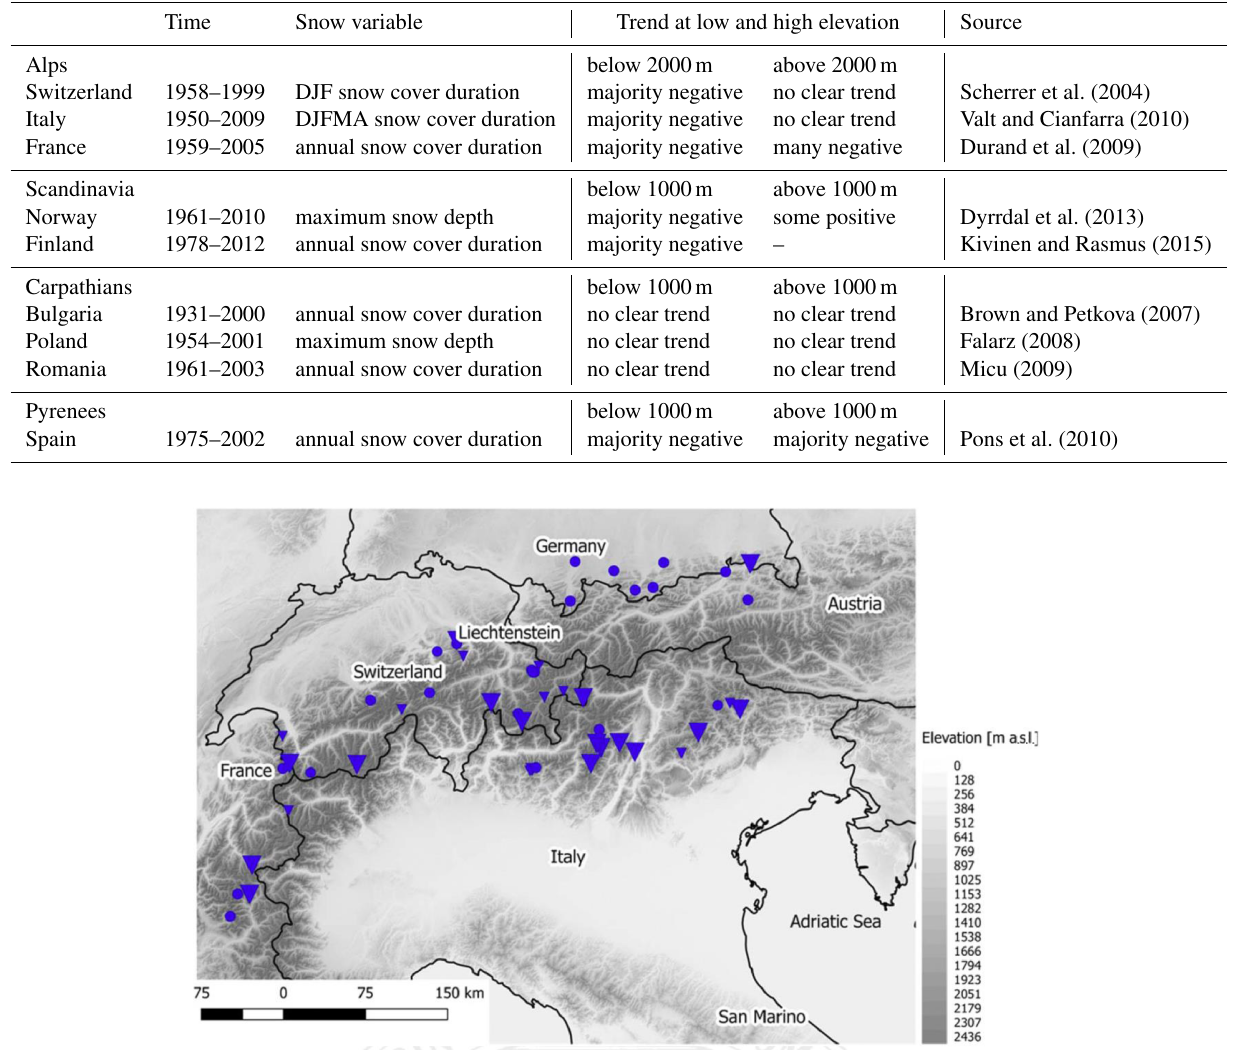
Figure 1. Geographical distribution of the 45-year trend (1968–2012) for 1 April snow water equivalent (SWE) in the Alps. All stations show a negative trend. Large triangles indicate significant trends ( p = 0.05) and small triangles indicate weakly significant trends ( p = 0.2). Circles represent stations with no significant trend ( p = 0.2). The elevation is given in gray. (Adapted from Marty et al.,